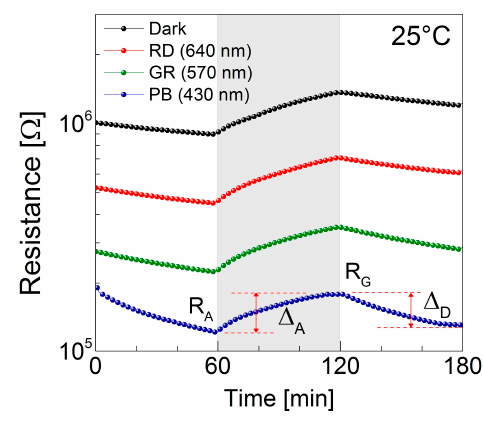
Figure 2. WO 3 nanofibers responses at 25 °C to 400 ppb NO 2 under different illuminating